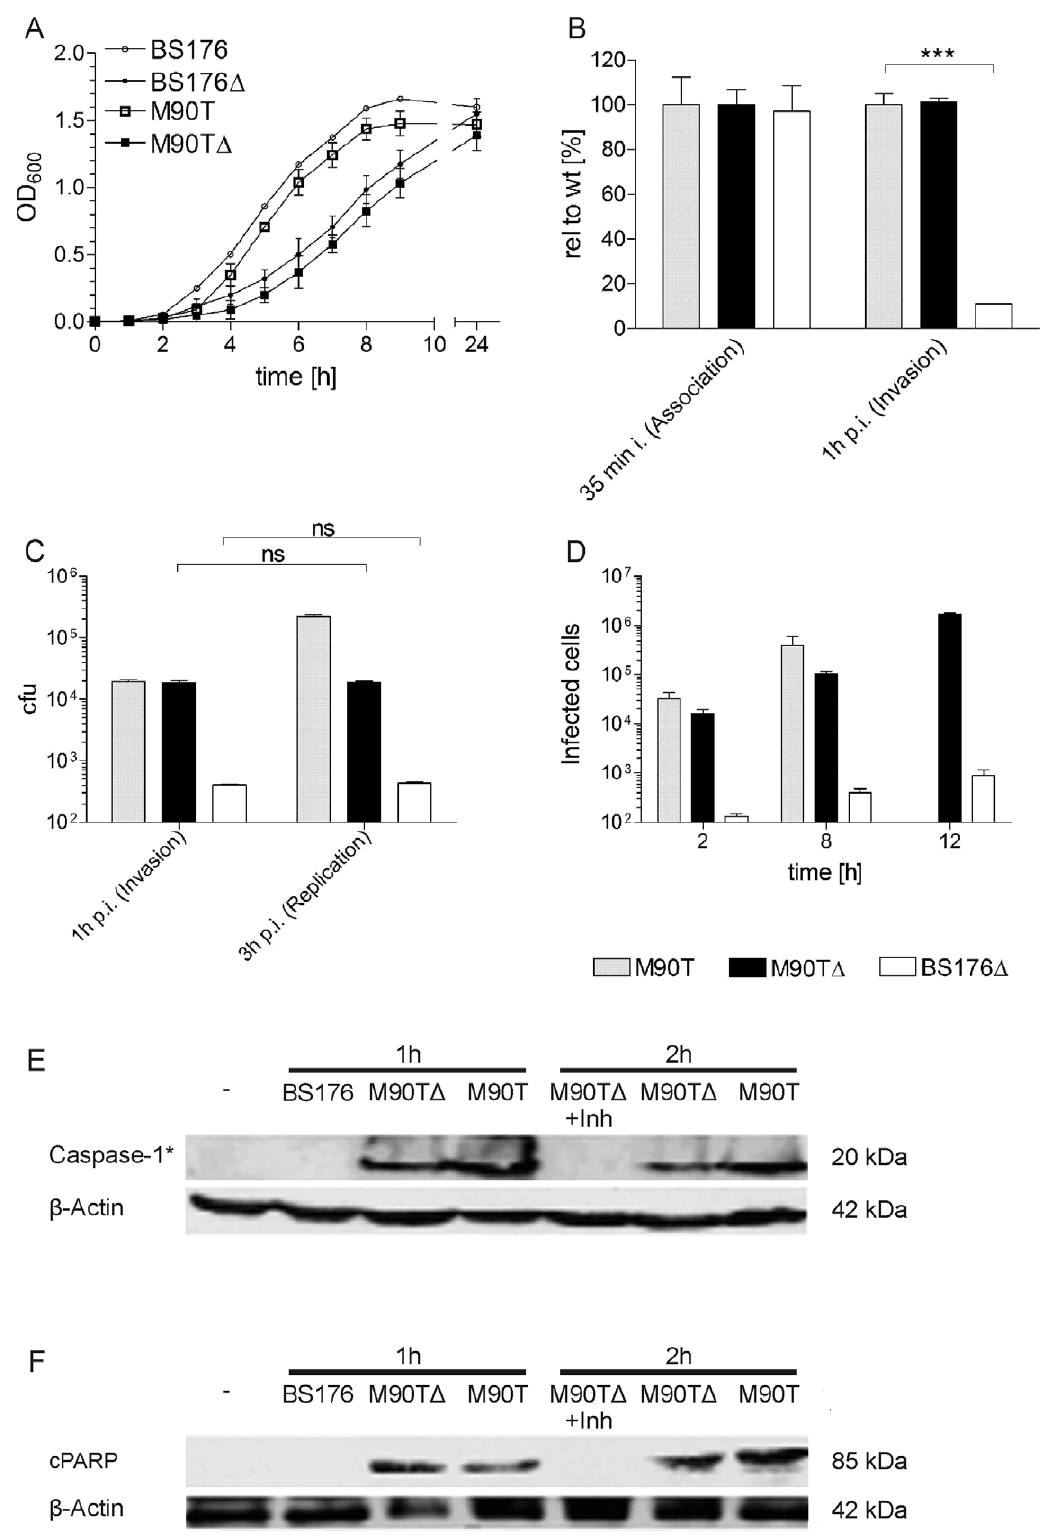
Figure 1. Invitro characterization of aroA mutants. (A) Determination of extracellular growth rate in LB medium. (B) Invasion assay (gentamicin protection assay). CFUs are shown relative to the wt M90T. (C) Intracellular replication rate in HeLa cells. (D) Cell to cell spread in HeLa cells assessed by L-Top agar assay. Western blot analysis for caspase-1 activation (caspase-1*) (E) and apoptosis induction was performed in J774A.1 Macrophages (PARP cleavage - cPARP) (F). Bars represent means + /- SD of three different experiments, *** P , 0.001. BS176: Shigella flexneri BS176; BS176 D : Shigella flexneri BS176 D aroA ; M90T: Shigella flexneri M90T; M90T D : Shigella flexneri M90T D aroA .